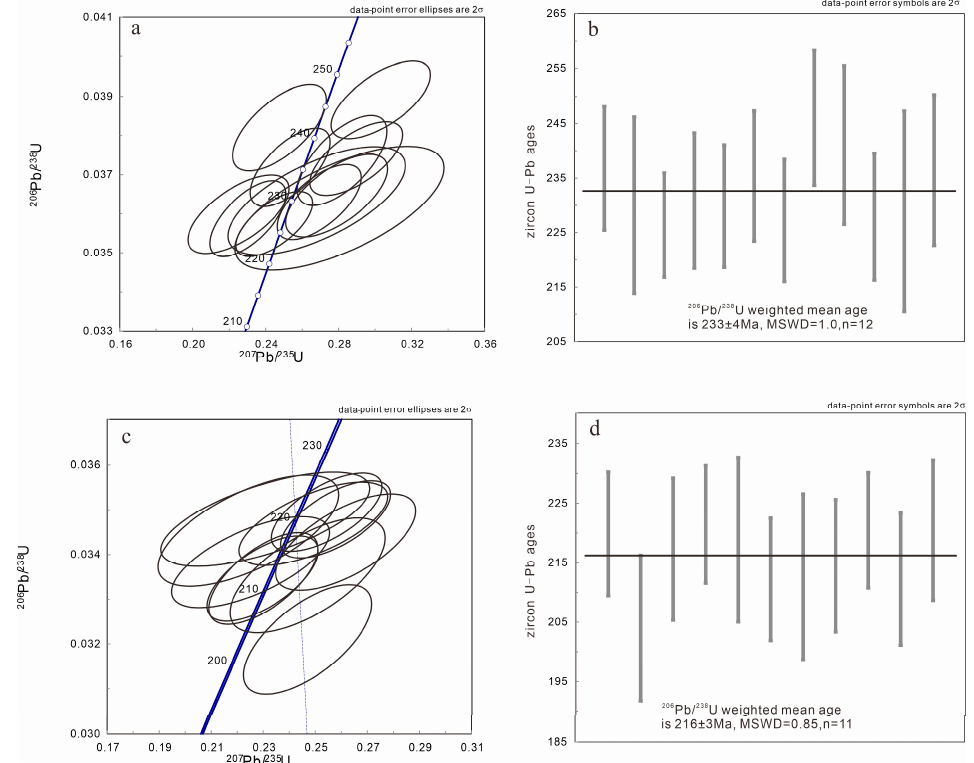
Figure 4. Zircon LA-ICP MS U-Pb concordia diagram ( a , c ) and weighted mean ages ( b , d ) for the Laocheng appinite.